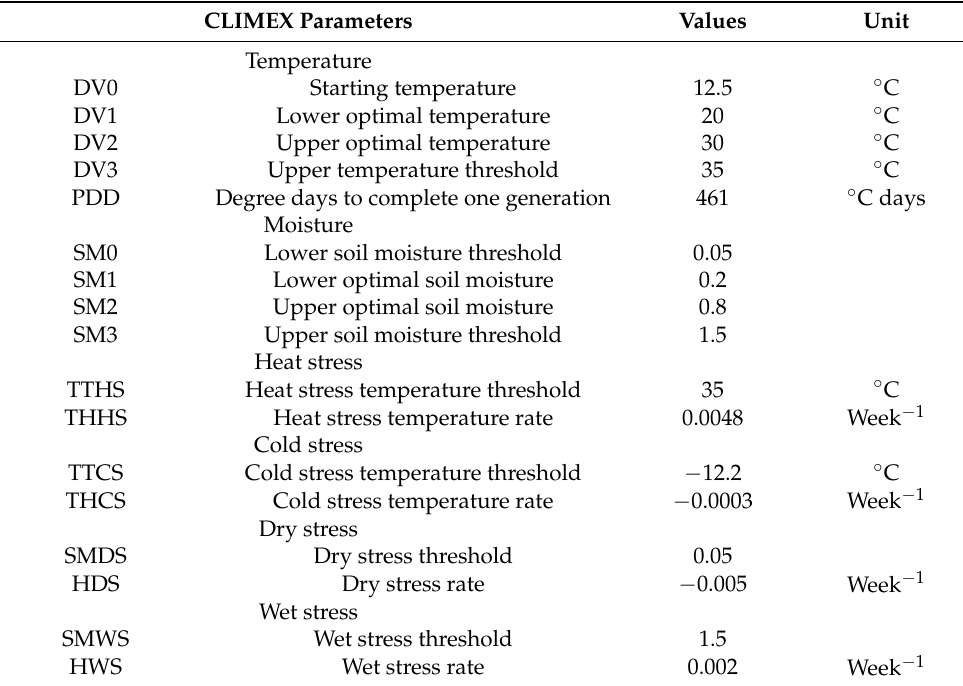
Table 1. CLIMEX parameter values used for P. interpunctella